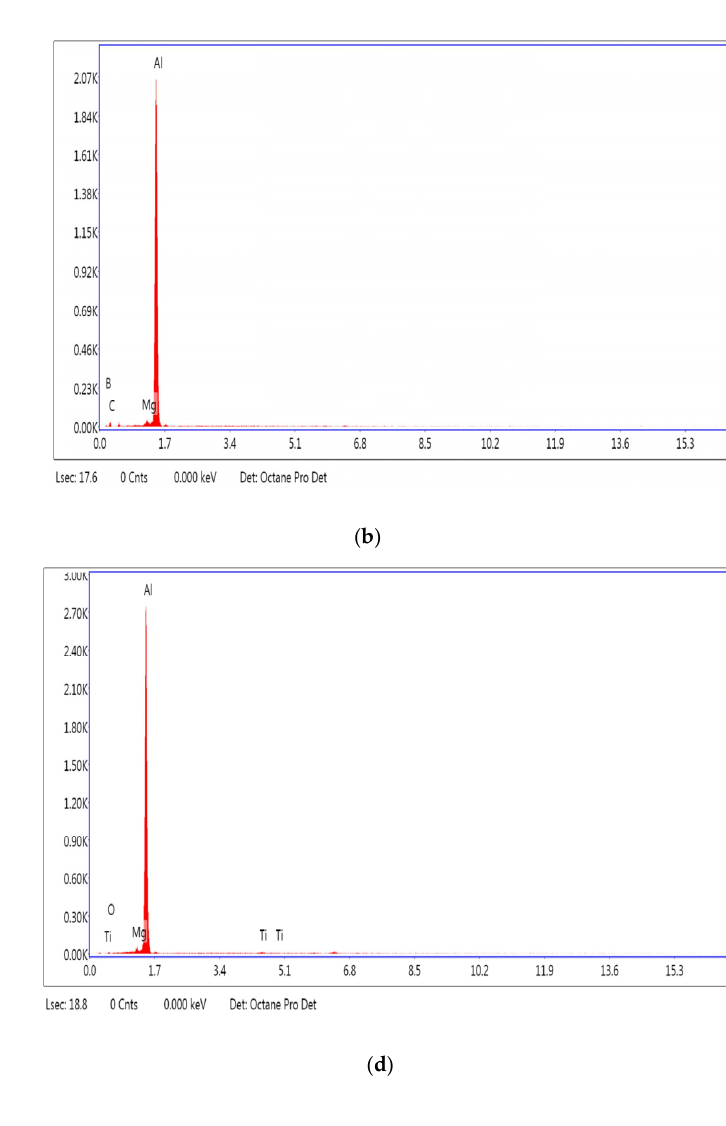
Figure 2. SEM images of FSPed AA7075 base metal.